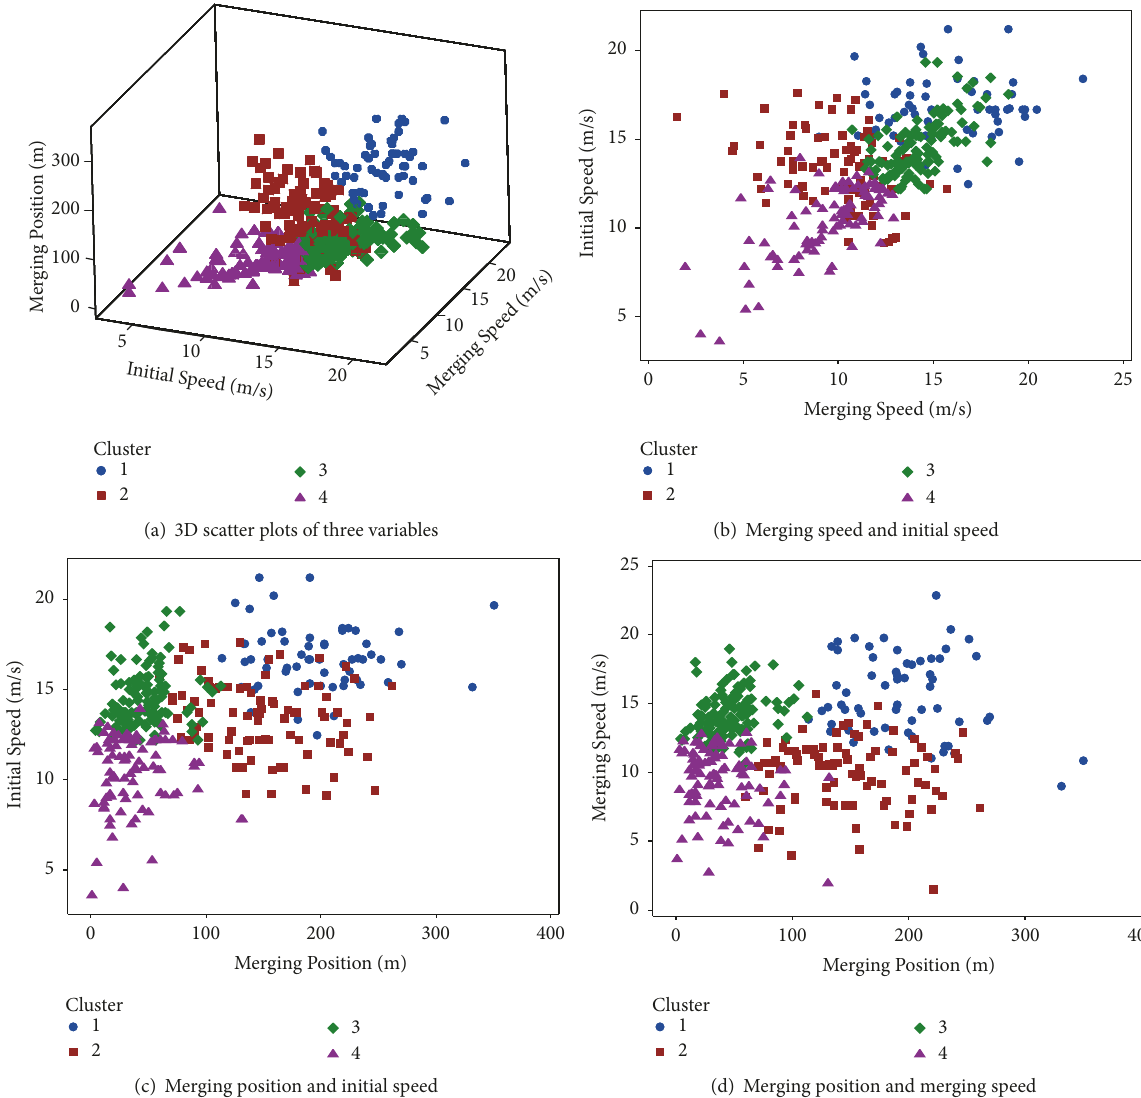
Figure 2: 3D scatter plots and 2D scatter plots of two-step clustering result.